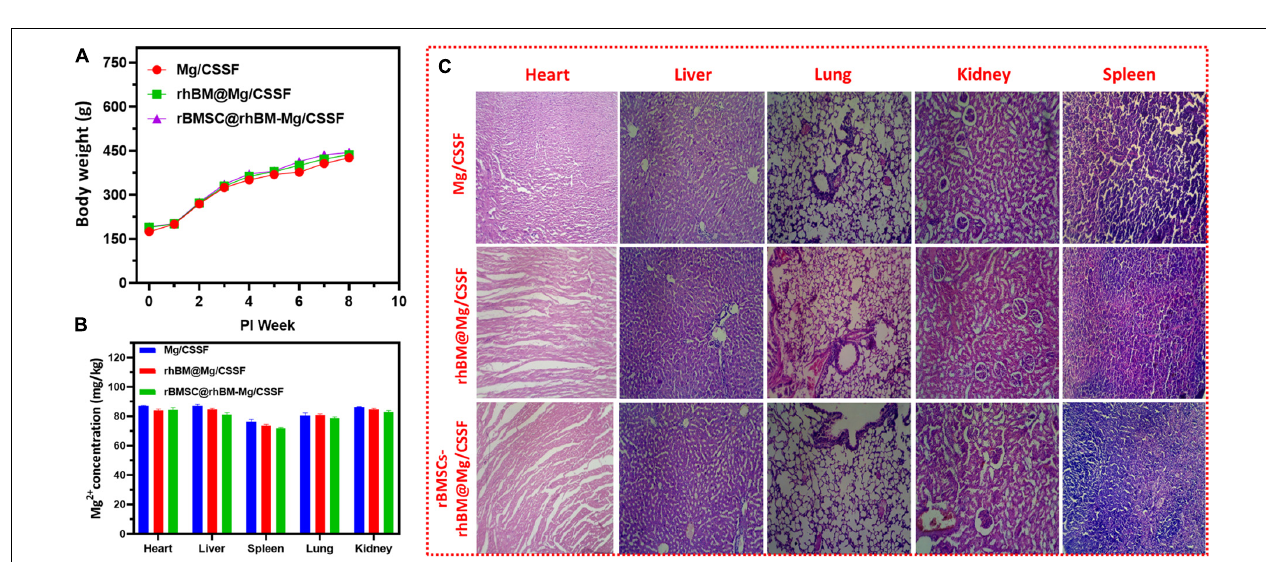
FIGURE 10 | In vivo biosafety assessments: (A) body weight changes of RD rats after implantation of hydrogel groups according to postimplantation time (weeks). (B) Quantitative observations of average value of Mg 2 + ions concentrations in the different organs of treated models after 8 weeks and (C) histological observations of treated models’ microstructures of heart, liver, lung, kidneys, and spleen with H&E